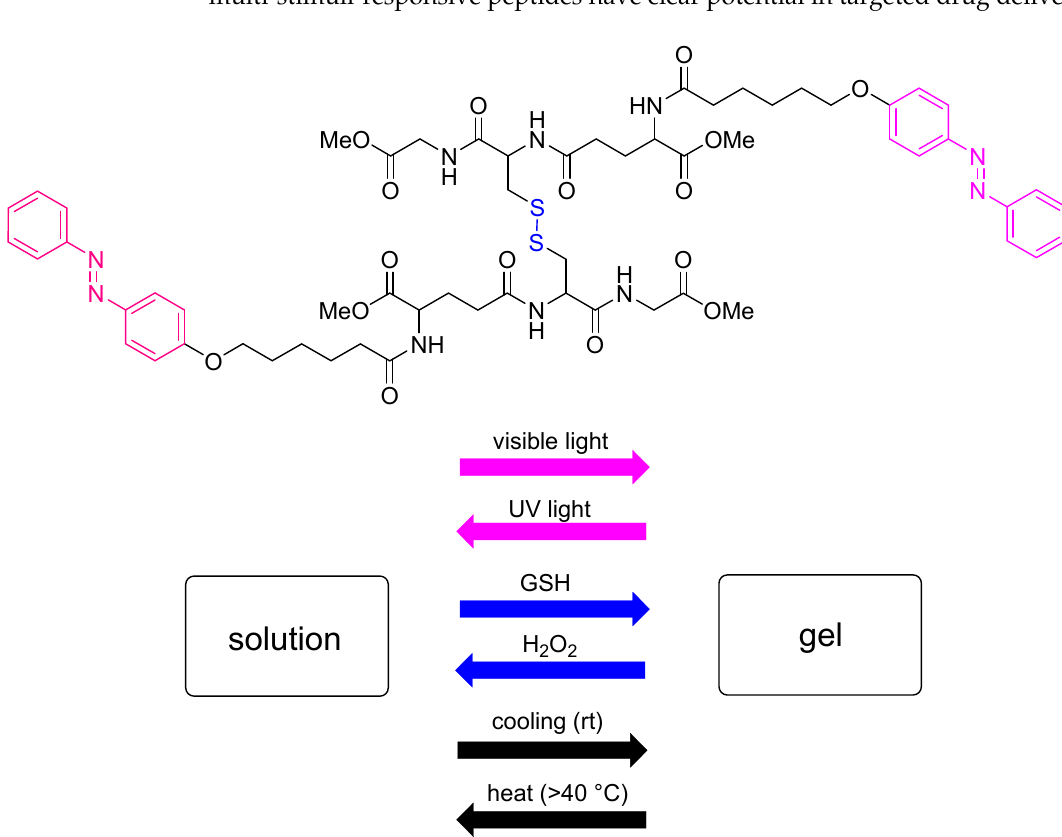
Figure 5. Multi ‐ stimuli ‐ responsive peptide hydrogel reported by Liu et al. (Adapted from [68]). Figure 5. Multi-stimuli-responsive peptide hydrogel reported by Liu et al. (Adapted from